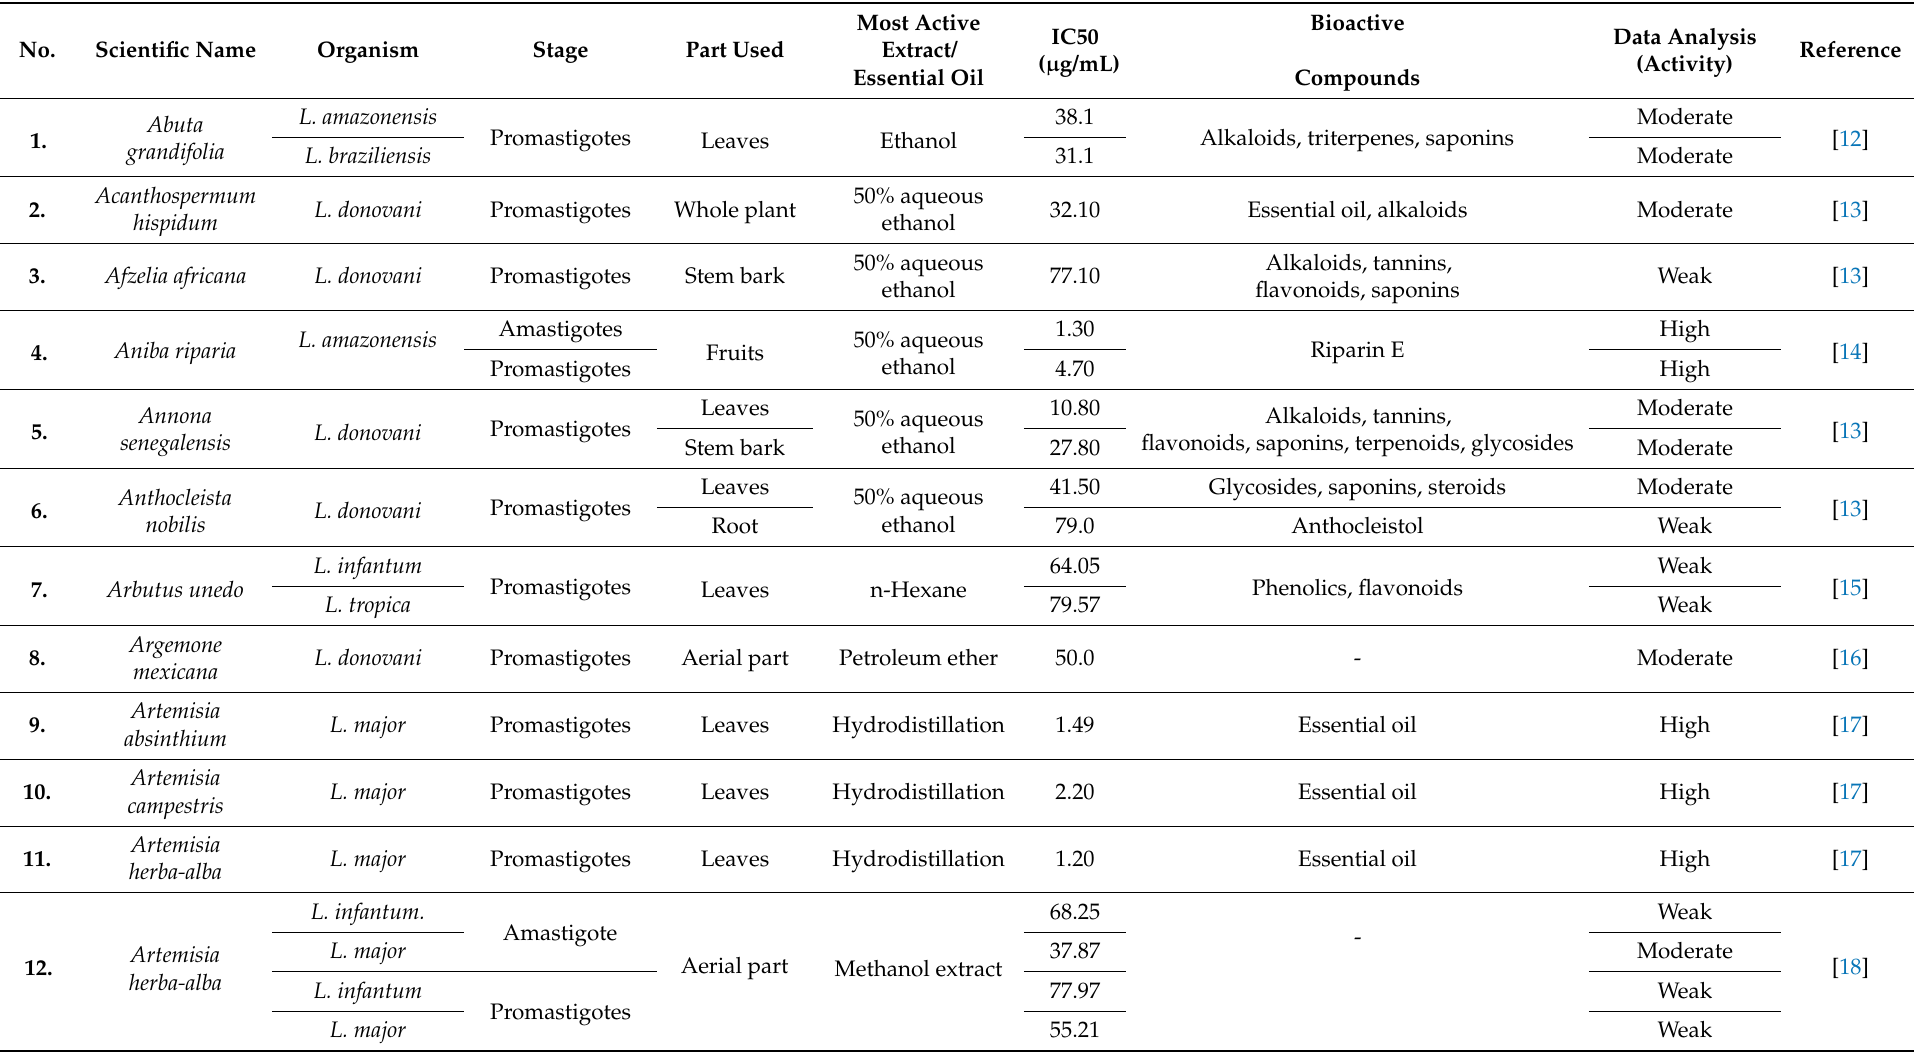
Table 3. Anti- Leishmania activity of medicinal plants in